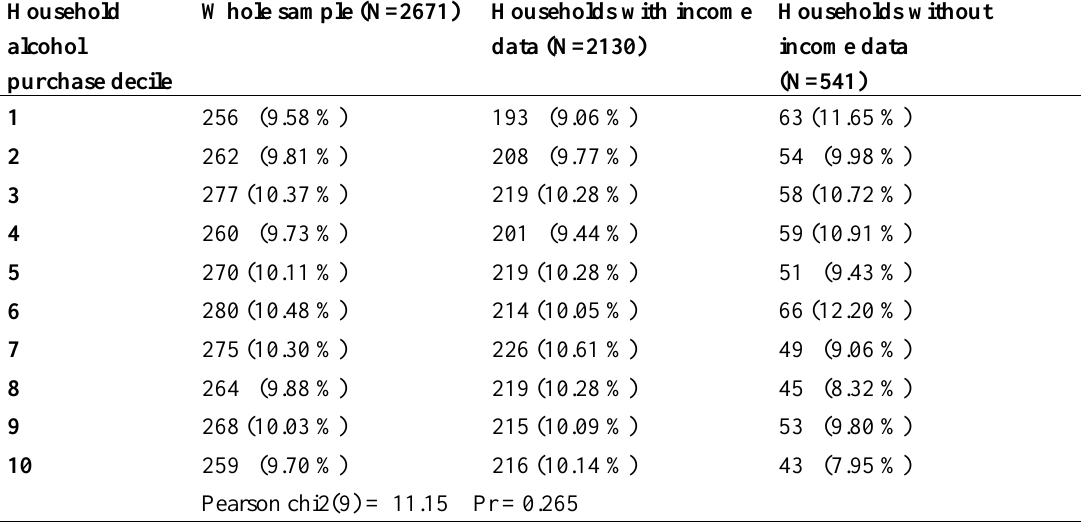
Household frequency by average weekly alcohol purchase level